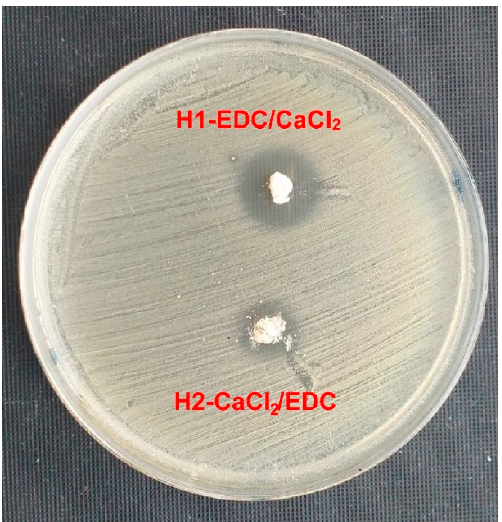
Figure 8. Growth inhibition zones obtained for the Staphylococcus aureus strain grown on the Mueller Hinton II medium after the application of H1-EDC/CaCl 2 and H2-CaCl 2 /EDC hydrogels.